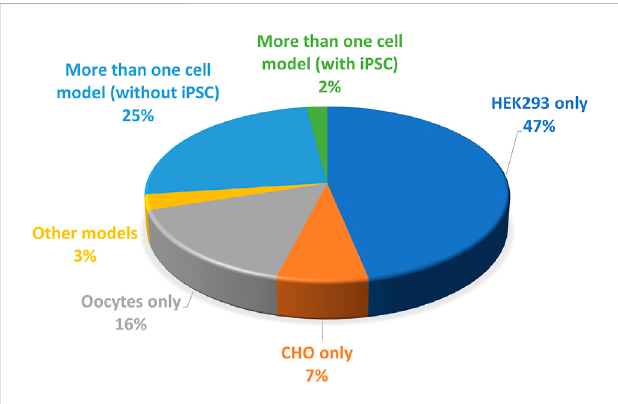
FIGURE 6 Pie chart presenting the percentage of the cell models used to study the KCNH2 variants (from analysis of Supplemental Table